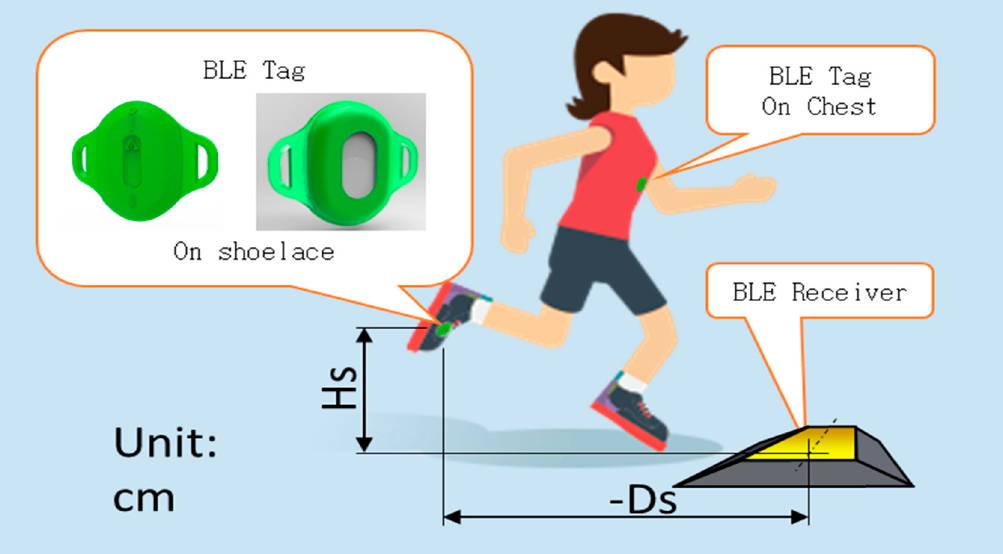
Figure 10. The received signal strength experiment.